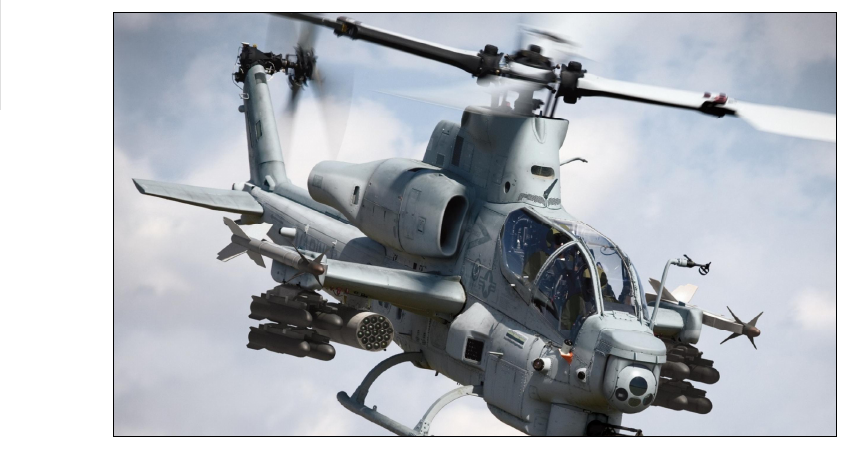
Рис .4 – Ударный вертолет Bell AH-1Z Viper «Zulu Cobra»